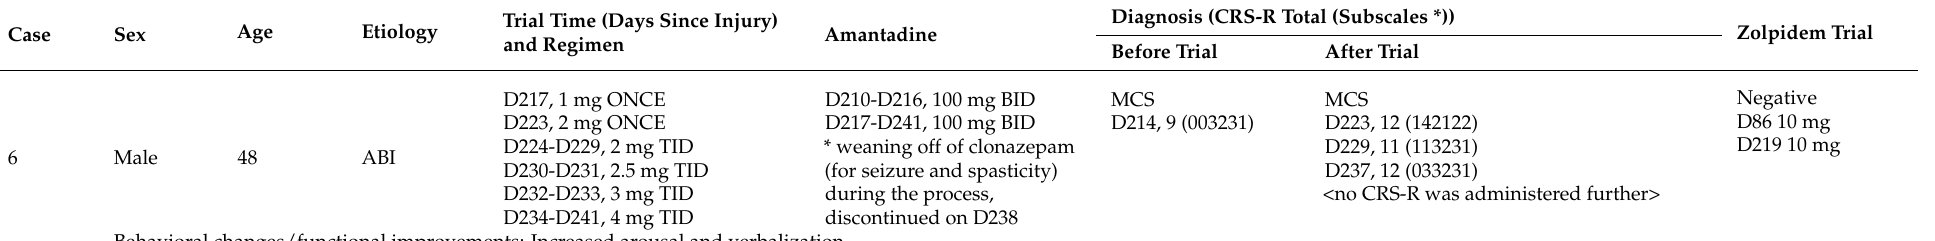
Table 4. The lorazepam responders’ demographics, trial information, and